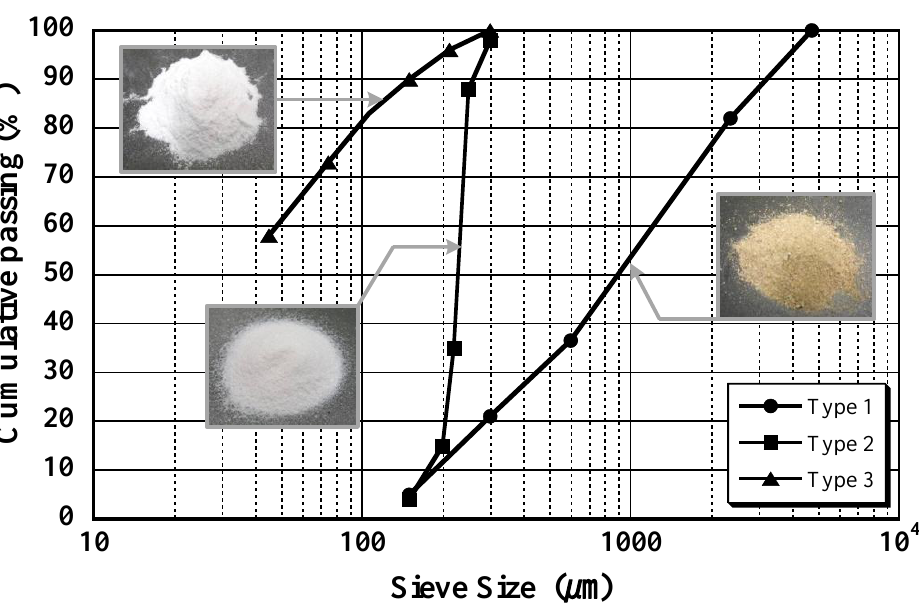
Figure 2. Types of sand.